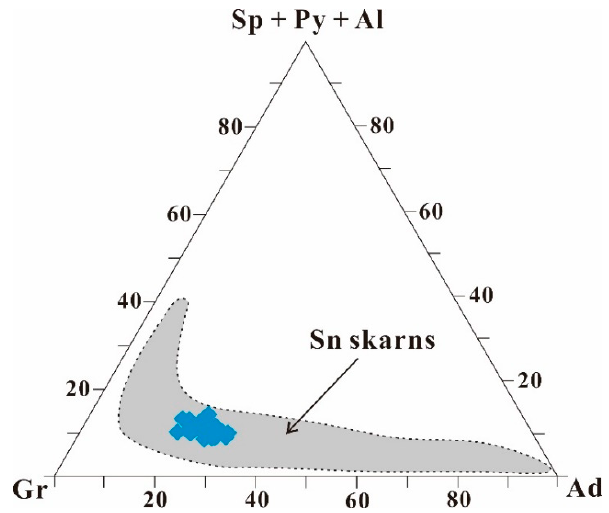
Figure 4. Ternary diagram summarizing garnet compositions in the Xianghualing skarn Sn deposit. Dashed area indicates the garnet composition ranges for skarn Sn deposits worldwide [44]. Abbreviations: Ad = andradite; Gr = grossular; Sp = spessartine; Py = pyrope and Al = almandine.